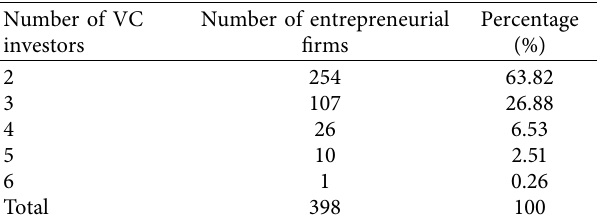
Figure 1: The theoretical model. KHS: knowledge heterogeneity of VCS; IC: intellectual capital of entrepreneurial firms; IP: innovation performance of entrepreneurial firms; ES: equity structure of Table 1: Distribution of characteristics of the number of syndications.